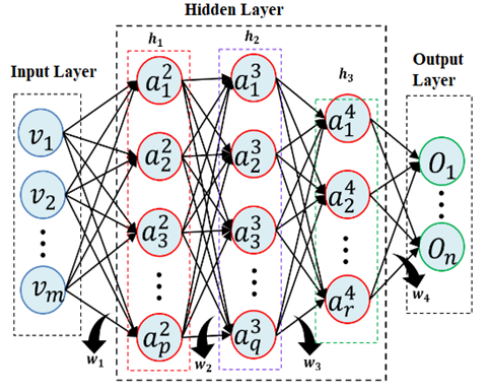
Figure 1. A DNN with three hidden layers